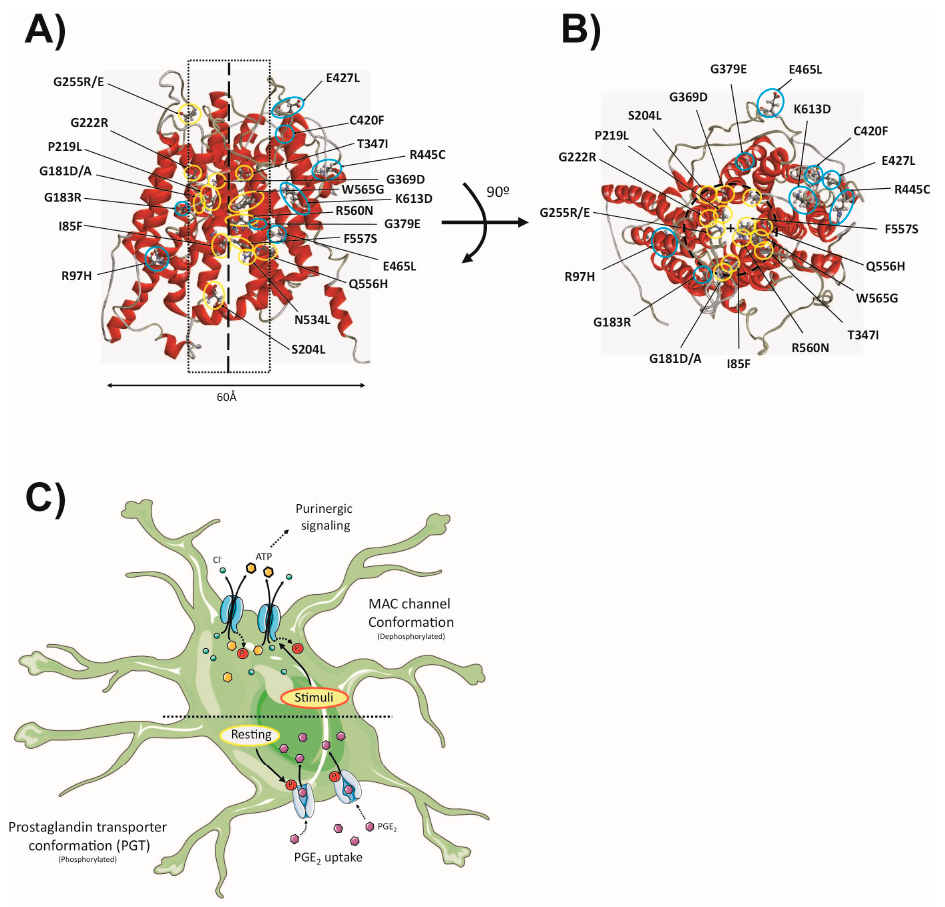
Figure 4. The SLCO2A1 protein, homology model and physiological role. ( A ) A 3D homology model of the SLCO2A1 protein based on the crystal structure of the E. coli glycerol-3-phosphate transporter (PDB ID: 1PW4A), constructed using the I-TASSER® software, as described elsewhere [139]. The protein is shown from the membrane plane. All the missense mutations found in pachydermoperiostosis patients are shown, including the charge-neutralized mutants, K613G and R560N. The thick dashed line indicates the central axis of the protein, and the thin dashed rectangle delimits a proximity threshold to the central axis. The residues that are close to (yellow), or far from (blue) the central axis, are highlighted with coloured circles. Notice the preferential location of most mutants to the vicinity of the central axis. ( B ) The top view of the homology model. The central cross represents the central axis, and the dashed circle delimits the proximity area. ( C ) The hypothetical physiological role of the SLCO2A1 protein. The horizontal dashed line in the centre of the cell highlights the dual behaviour of the protein either in the prostaglandin transporter (PGT) conformation (down) or the Maxi-Cl − channel (MAC) conformation (up). Under resting conditions, the phosphorylated SLCO2A1 protein behaves as the PGT, allowing for PGE 2 uptake and its clearance from the extracellular fluid. Various stimuli (osmotic swelling, hypoxia, salt stress, patch excision, etc.) can trigger protein dephosphorylation, and the activation of the SLCO2A1-MAC activity (up). Released ATP would be able to mediate autocrine or paracrine purinergic signalling.